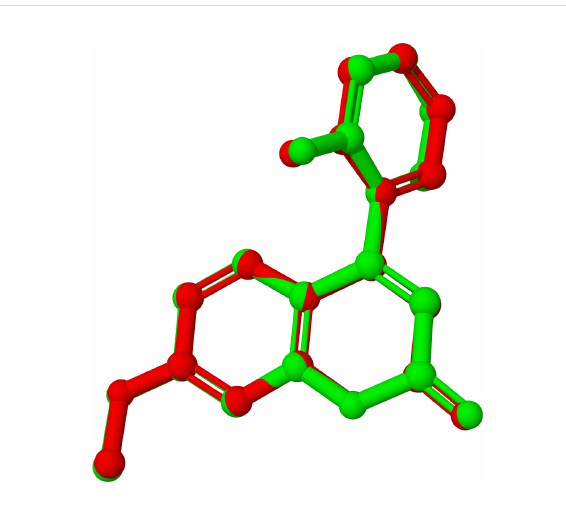
Figure 4: Superposition of single-crystal X-ray structure (red) and DFT-optimized structure (green); RMSD 0.3 Å (hydrogen atoms omitted for clarity).